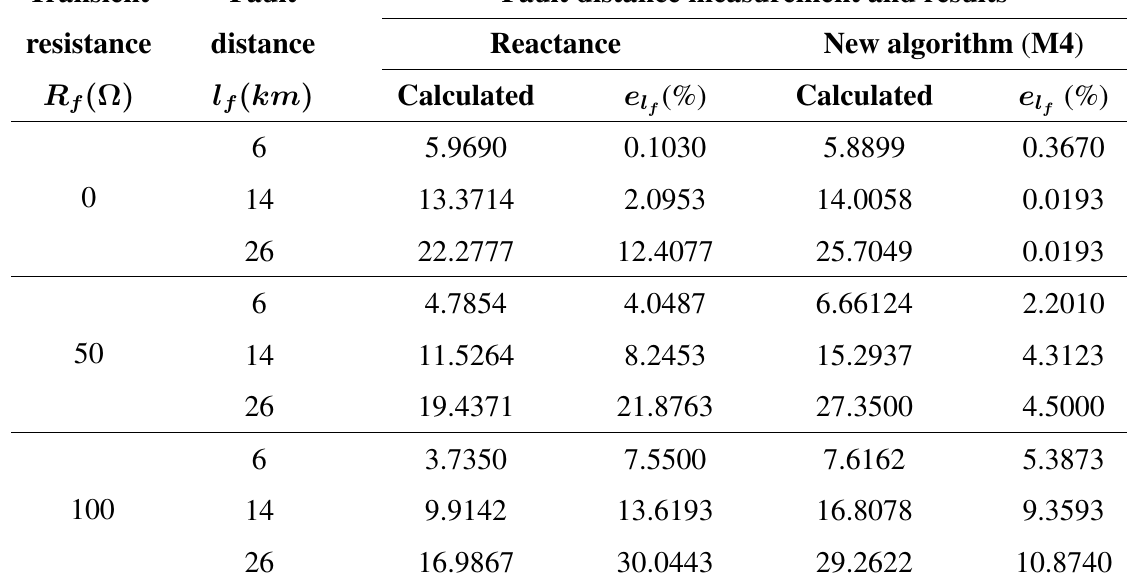
Table 7. The l calculation when locomotive is a constant power f